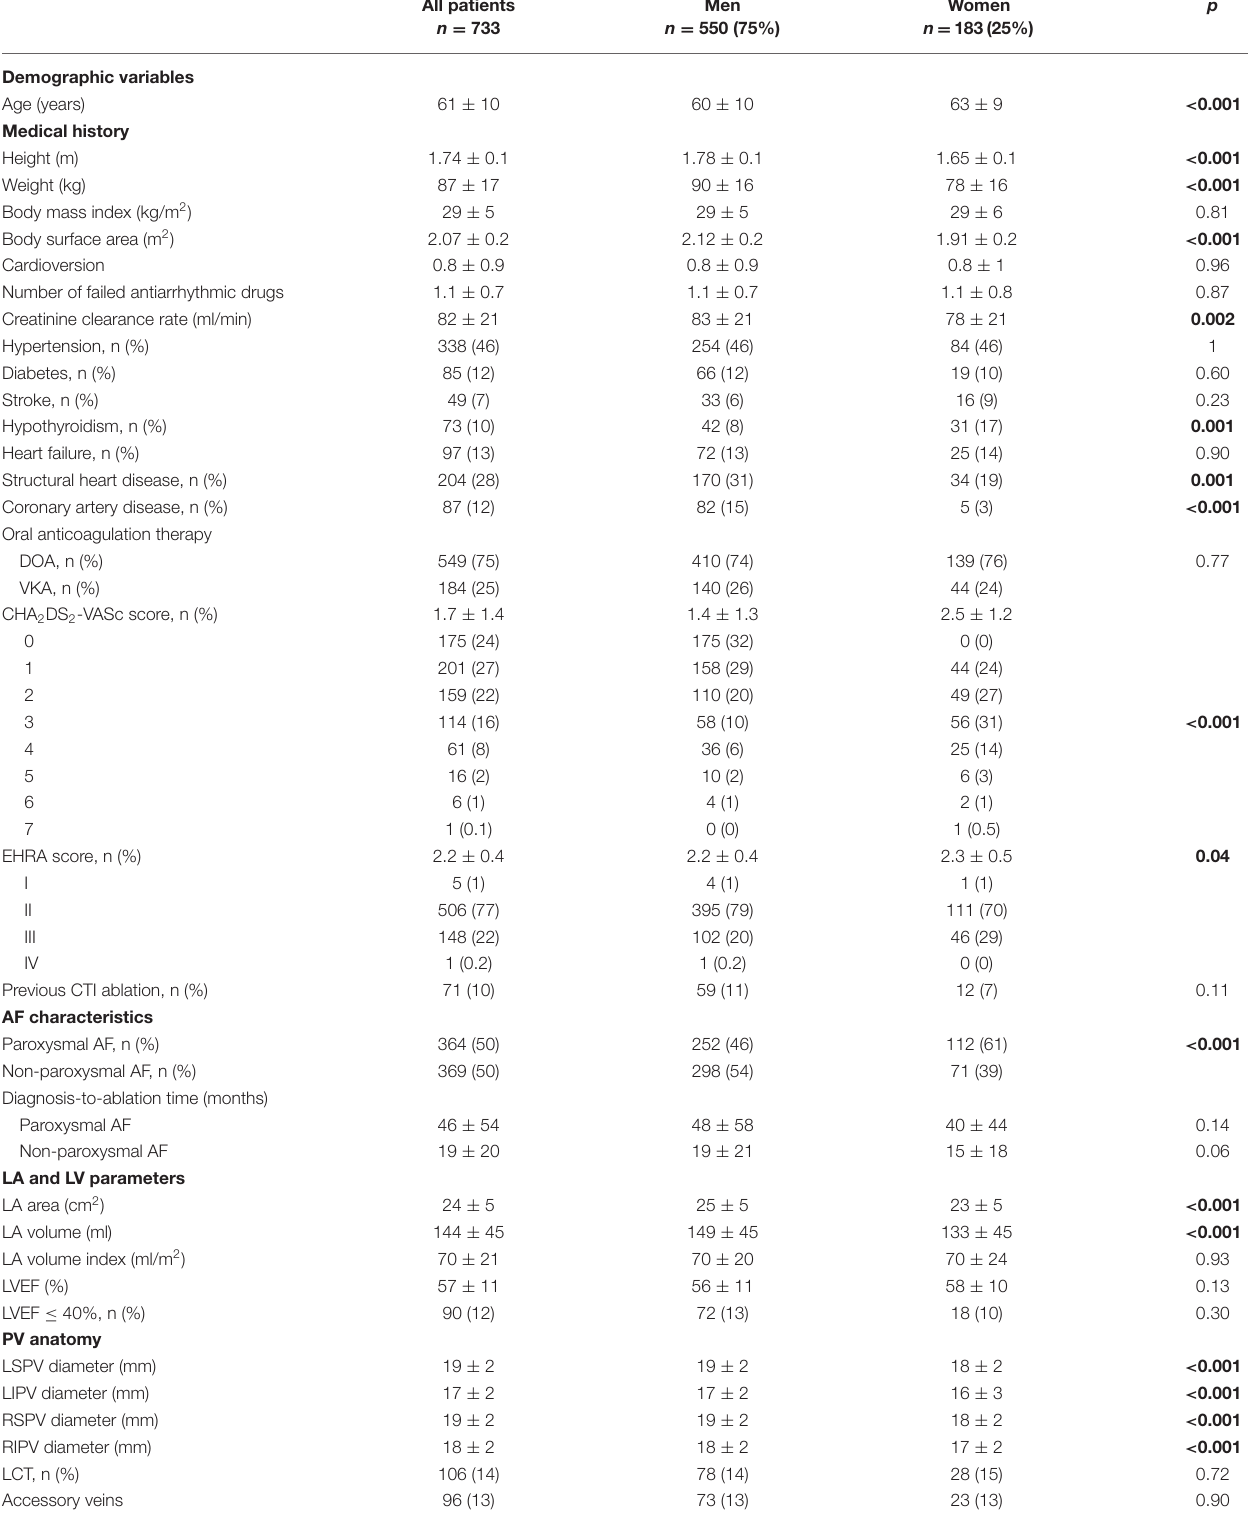
TABLE 1 | Characteristics of the study